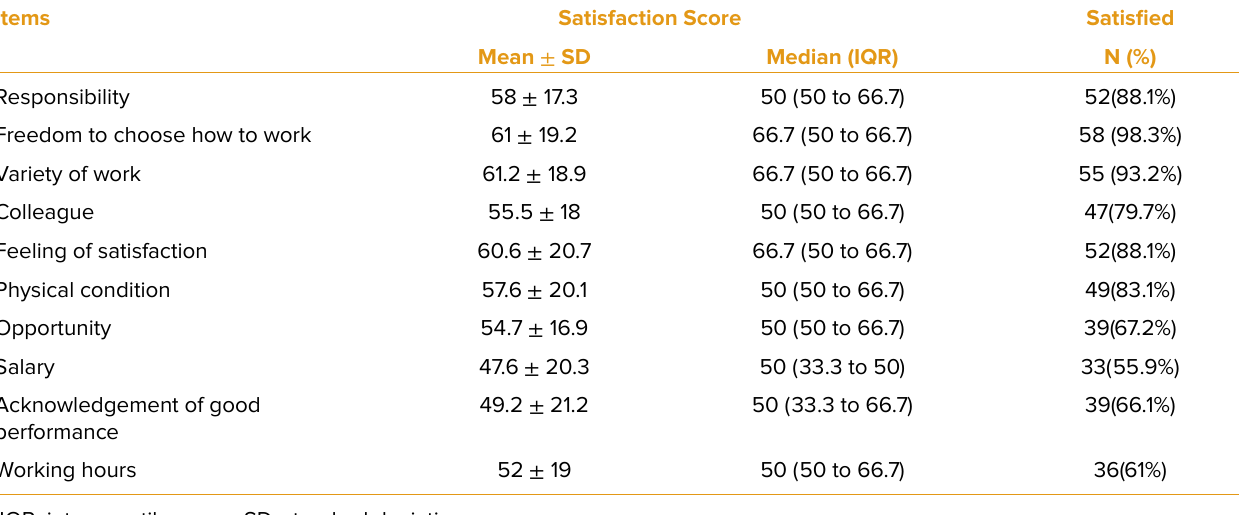
Table 2. Mean job satisfaction scores of study participants for every 10 questions of the questionnaire.